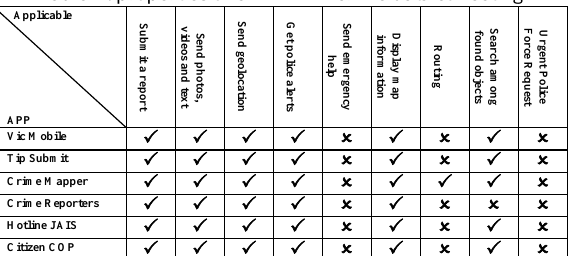
Table 1: properties of all APP in crime data collecting Applicable